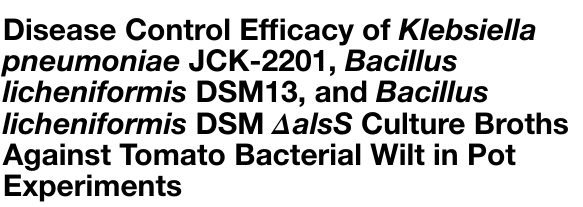
K. pneumoniae ( Supplementary Figure 2 ). The JCK-2201 strain